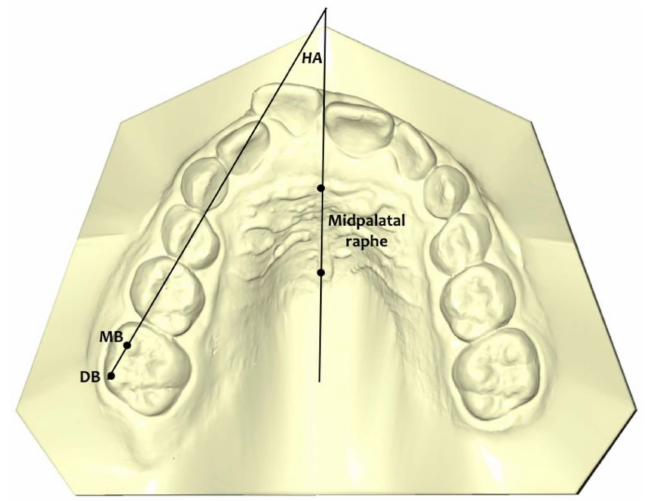
Figure 1. Henry’s angle (HA) formed between the mid-palatal raphe and the line passing through the mesiobuccal (MB) and distobuccal (DB) cusps of the maxillary first molar. All patients were instructed to wear their aligners full-time, excluding meals and tooth brushing. The patient changed the aligners every 7 days and every 4 stages the clinician checked for good aligner fitting and the position of the attachments. The mean number of aligners was 32 for the maxillary arch. If new scans were necessary to improve the fit of the aligners due to dental exfoliation and eruption, the prescription form was settled to con- tinue the treatment until reaching the same final position as the first approved